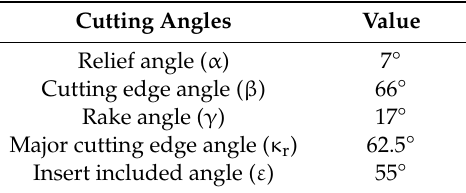
Figure 2. Specimen positioning and turning operation tool. Table 3. Cutting angles setup.